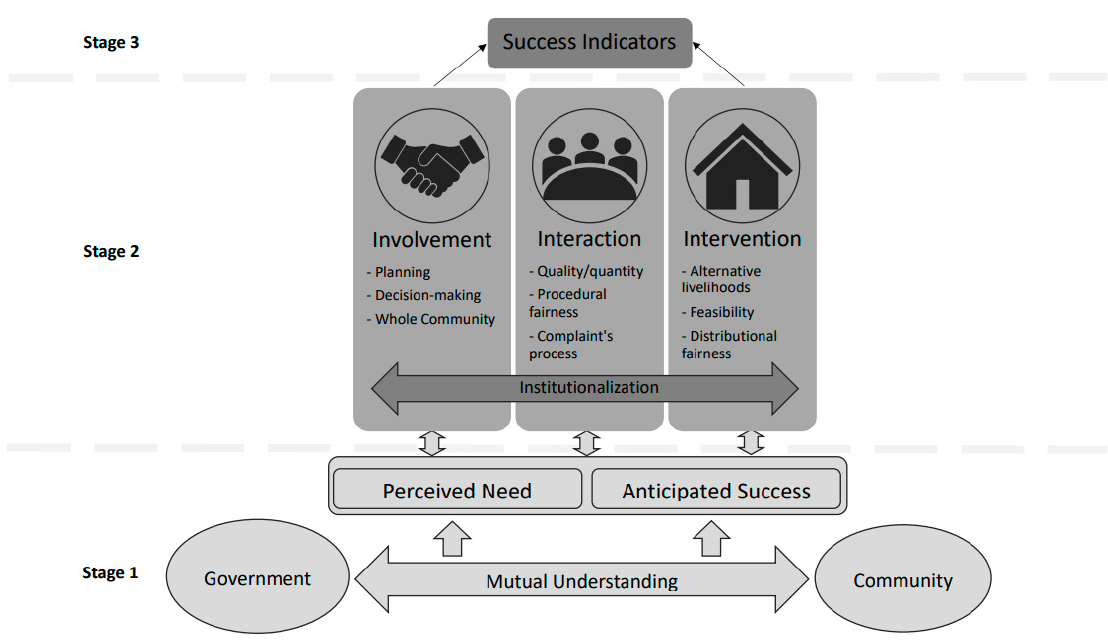
Figure 3. Three-stage model for developing a social license to restore